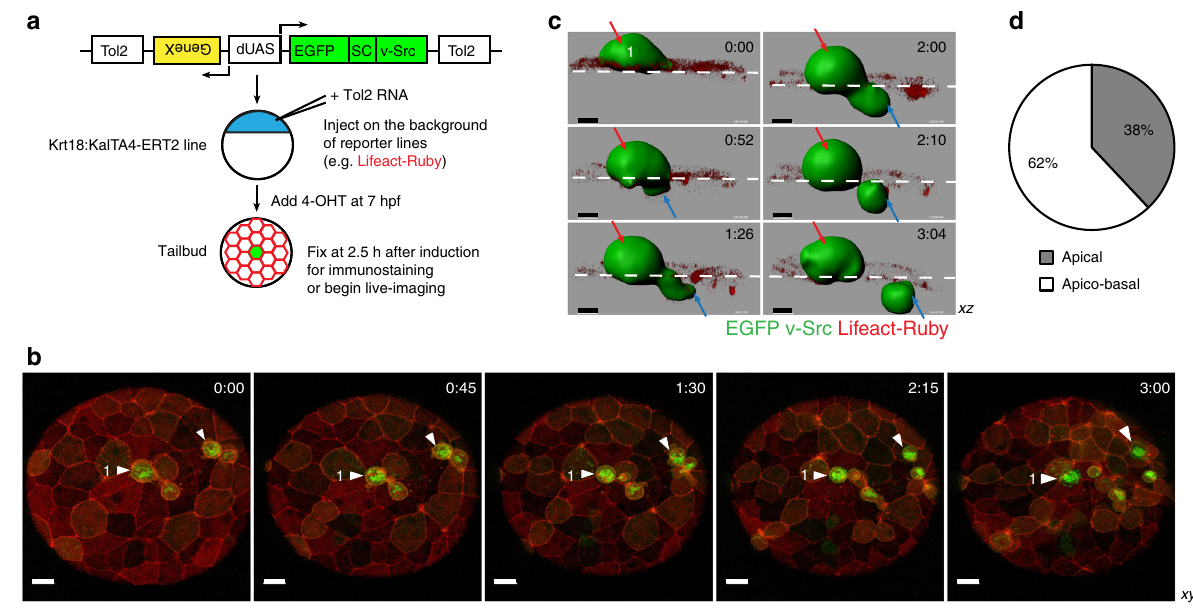
Fig. 1 vSrc-transformed cells become apicobasally extruded from the EVL layer. a Experimental design. Fish embryos obtained from a transgenic line expressing tamoxifen-inducible Gal4 speci fi cally in the EVL (Krt18:KalTA4-ERT2) are injected at one-cell stage with constructs encoding oncogenes and effectors/markers under the control of the bi-directional UAS, dUAS 8 . At 50 – 70% epiboly, embryos are treated with tamoxifen to induce oncogene expression. At tailbud (2 – 3 h from induction, 10 h post fertilization), embryos are fi xed for quanti fi cation or mounted in agarose for live-imaging. b Time- lapse imaging of vSrc cell extrusion from the EVL of the zebra fi sh embryo. Transgenic embryos obtained from a line expressing an RFP-actin marker (red) speci fi cally in the EVL (Krt18:Lifeact-Ruby) line crossed with the Krt18:KalTA4-ERT2 line were injected with the UAS:EGFP-vSrc construct (green). Movies were taken over 4 h. Frames were extracted from a representative movie at indicated times from the tailbud stage ( t = 0). White arrowheads indicate cells that become extruded. “ 1 ” indicates the cell segmented in c . Scale bar, 30 µ m. c Segmented time-lapse images of vSrc cell extrusion. The surface function was used to segment the GFP-positive vSrc cell from b over time using the Imaris software. In this cross section of the embryo ( xz view), the cell is undergoing an apicobasal split (apical part extruding outside of the embryo is marked with red arrow and the basal part extruding towards the deep cells with blue arrow). The dashed white line indicates the surface of the embryo. Scale bar, 10 µ m. d Quanti fi cation of vSrc-mediated cell extrusion type based on time-lapse imaging. Apicobasal extrusion refers to extrusions in which the basal part contains at least a third of the original cell volume. Seven embryos were imaged in seven independent experiments (total number of extrusions: n Src =